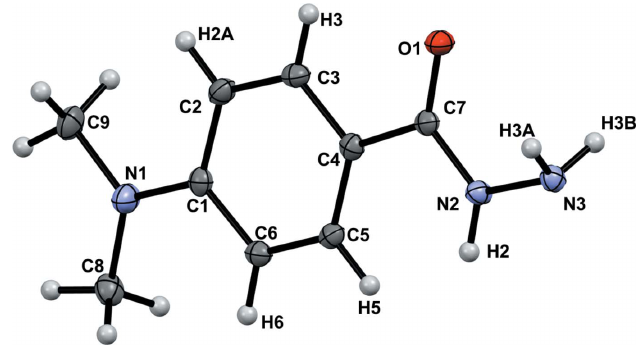
Figure 1 Atomic numbering and displacement ellipsoids at the 50% probability level for ( I